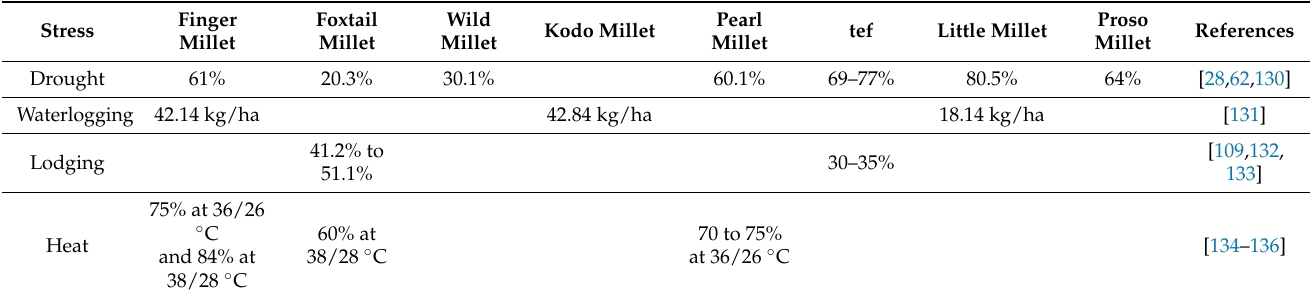
Table 1. Effect of different abiotic stresses such as drought, heat, waterlogging, and lodging stresses on the yield of millet crops. Data represent percent yield loss in kg · ha − 1 in response to a particular abiotic stress.